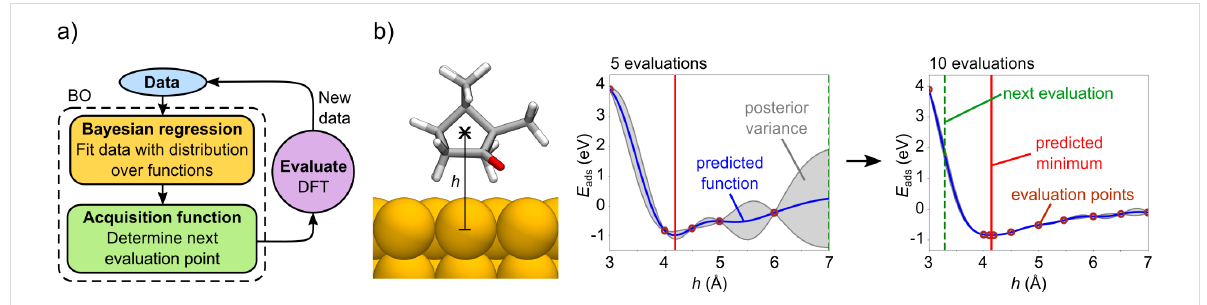
Figure 2: BOSS workflow and example performance. (a) Basic principle of the BOSS method, in which Bayesian optimization (BO) is applied itera- tively with DFT to build a surrogate model of the PES. (b) 1D example of the iterative process, in which the adsorption energy E ads of camphor on Cu(111) is predicted as a function of height h of the molecule from the surface. The predicted adsorption height is converged in five energy evalua- tions to within 0.1 Å. After ten evaluations, the posterior variance, which describes the uncertainty of the model, has become vanishingly small throug- hout the search region.